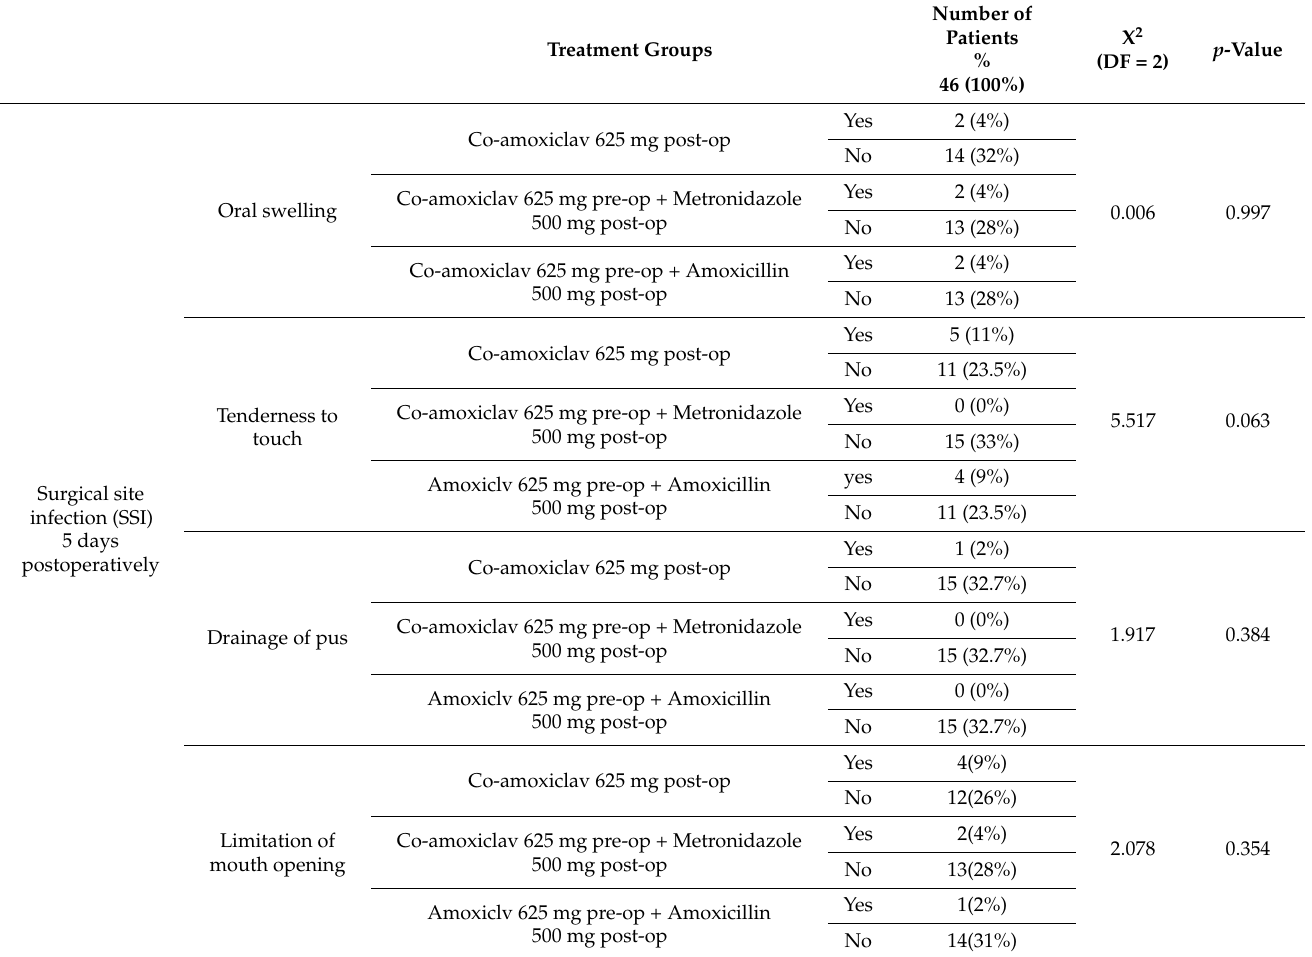
Table 3. Relationship between different regimens of oral antibiotics and SSI